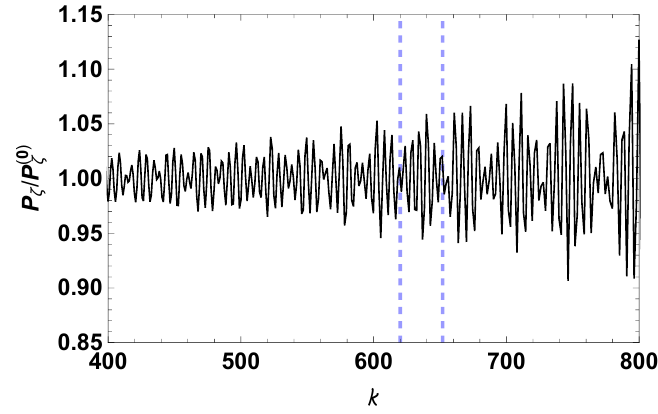
Figure 4 . The ratio P (cid:16) =P (0) in the high- k range from solving the system numerically. k is in unit (cid:16) of H . We (cid:12)x (cid:3) = 6 (cid:2) 10 3 H; M = 1020 H; m (cid:31) = 10 H; m h = 2 H; (cid:21) = 1. To clarify what we mean by \k-wavepacket," we have marked one between dashed blue